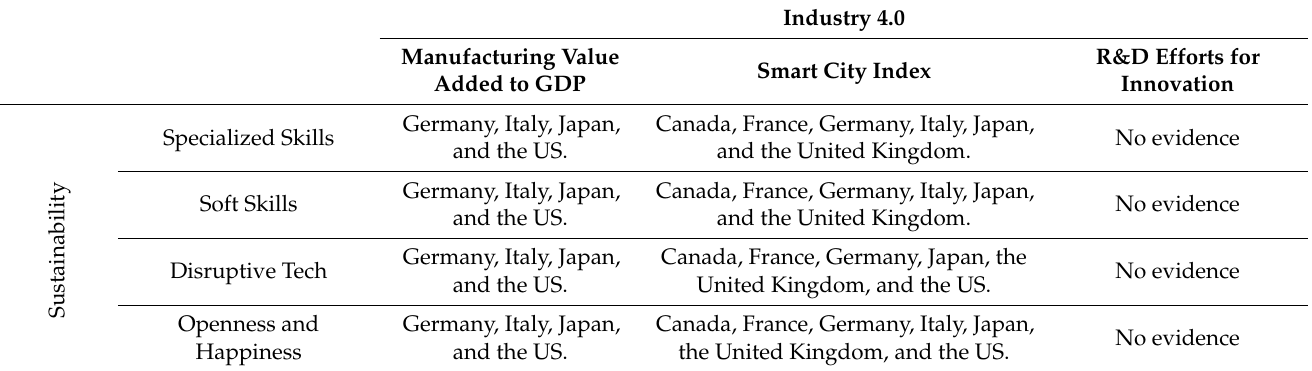
Table 3. Matrix relating the Open Data for Industry 4.0 and Open Data for